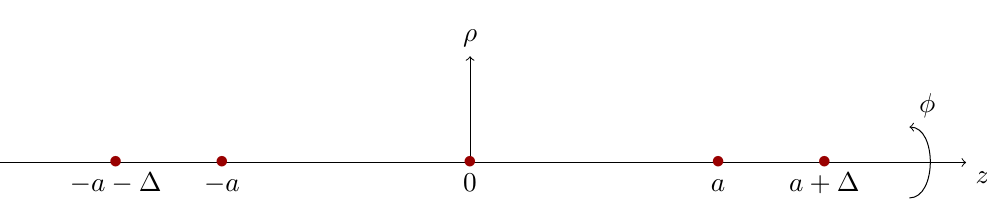
Figure 1 . The model we consider has 5 Gibbons-Hawking points arranged in a Z 2 symmetric manner along the z-axis. The locations of the points are determined by two scale parameters, a and ∆